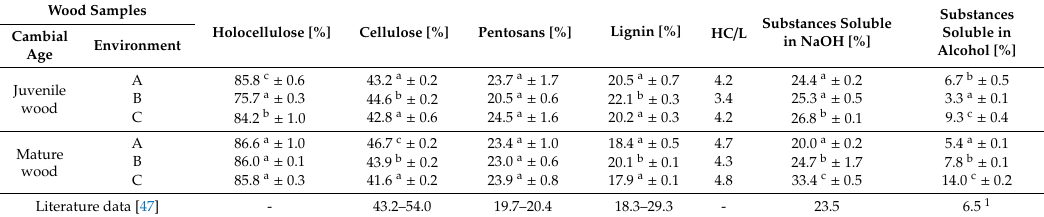
Table 2. Chemical composition of lime ( Tilia cordata Mill.)